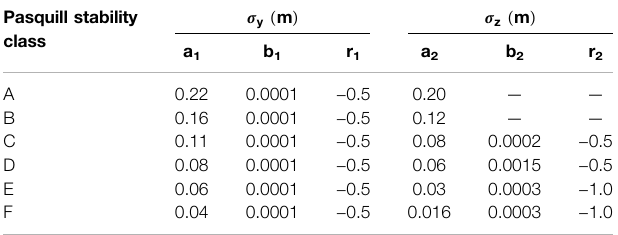
TABLE 1 | Constants for calculating dispersion coef fi cients in BRIGGS scheme (Mao et al., 2020). Pasquill stability